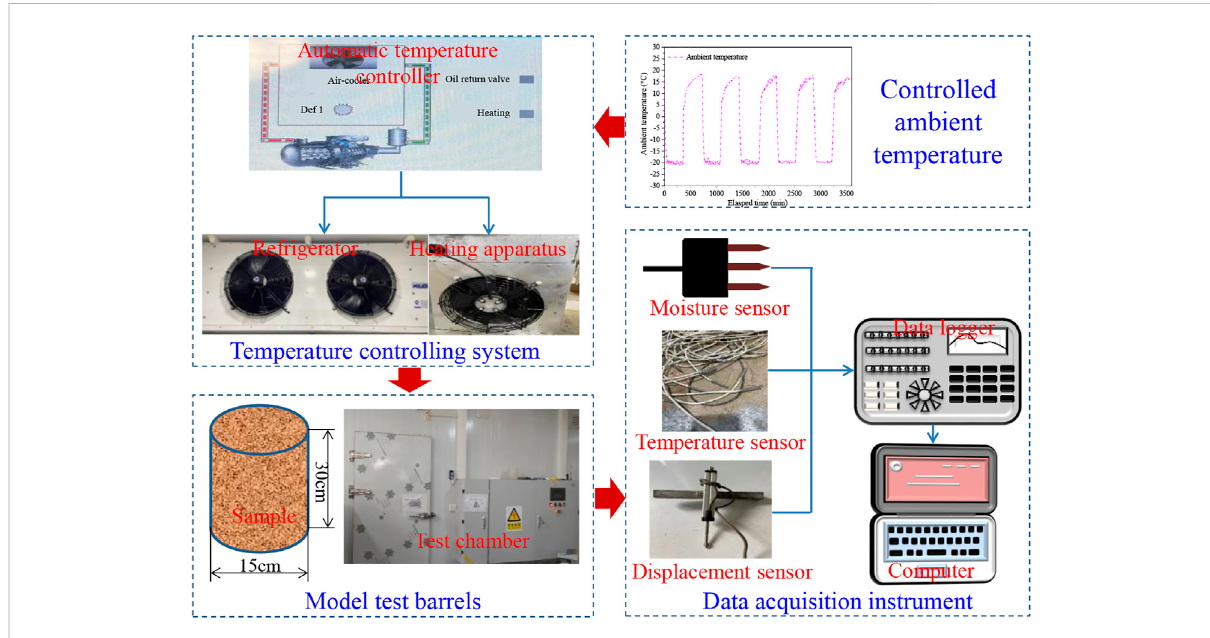
Schematic illustration of the experimental apparatus and controlled ambient